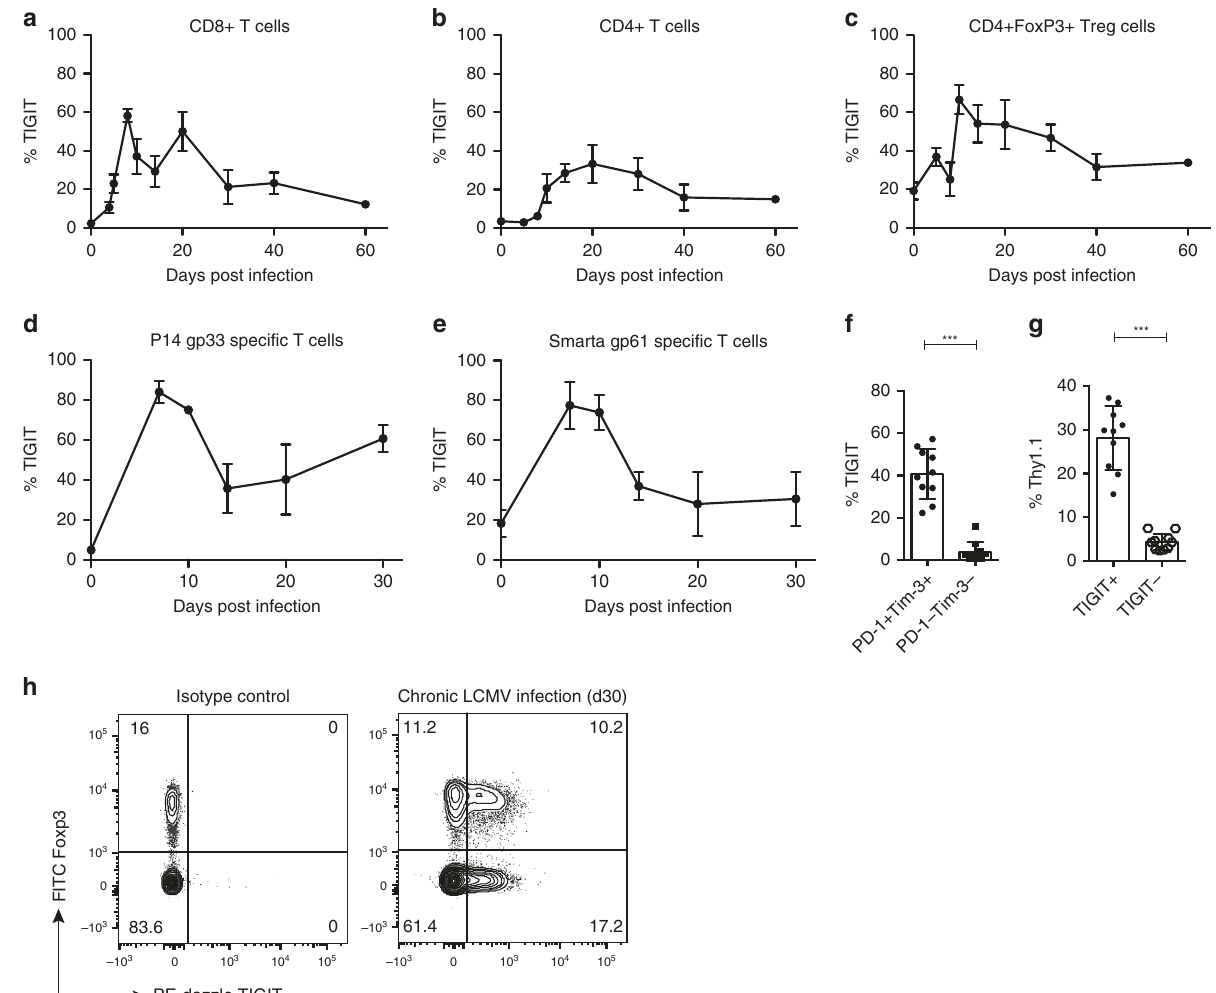
Fig. 1 TIGIT expression during chronic LCMV clone 13 infection. TIGIT expression on splenic T cells was analyzed after chronic LCMV clone 13 infection (2 × 10 6 FFU) using fl ow cytometry. Expression over time on ( a ) CD8 + T cells, ( n = 2 – 16), ( b ) CD4 + T cells ( n = 2 – 17), and ( c ) CD4 + FoxP3 + regulatory T cells ( n = 2 – 13) is shown. TIGIT expression on ( d ) P14 Ly5.1 + TCR transgenic CD8 + T cells speci fi c for gp33, ( n = 4 – 6) and ( e ) Smarta CD4 + T cells speci fi c for gp61 ( n = 4 – 7). f TIGIT expression on exhausted (PD1 + Tim-3 + ) or non-exhausted (PD1 − Tim-3 − ) CD8 + T cells on day 30 p.i. ( n = 10). g IL-10- Thy1.1 expression in Thy1.1-IL-10 reporter mice by TIGIT + and TIGIT - CD8 + T cells on day 30 p.i. ( n = 10). h Representative FACS plots of TIGIT expression on T cells on day 30 p.i. with chronic LCMV clone 13. Data represent 2 – 3 independent experiments. Each symbol in the scatter plot represents an individual mouse, and bar graphs indicate the mean value ± SD. Statistical values p < 0.05 (*), p < 0.01 (**), p < 0.005 (***) or ns (not signi fi cant, p > 0.05) determined by Welch ’ s t